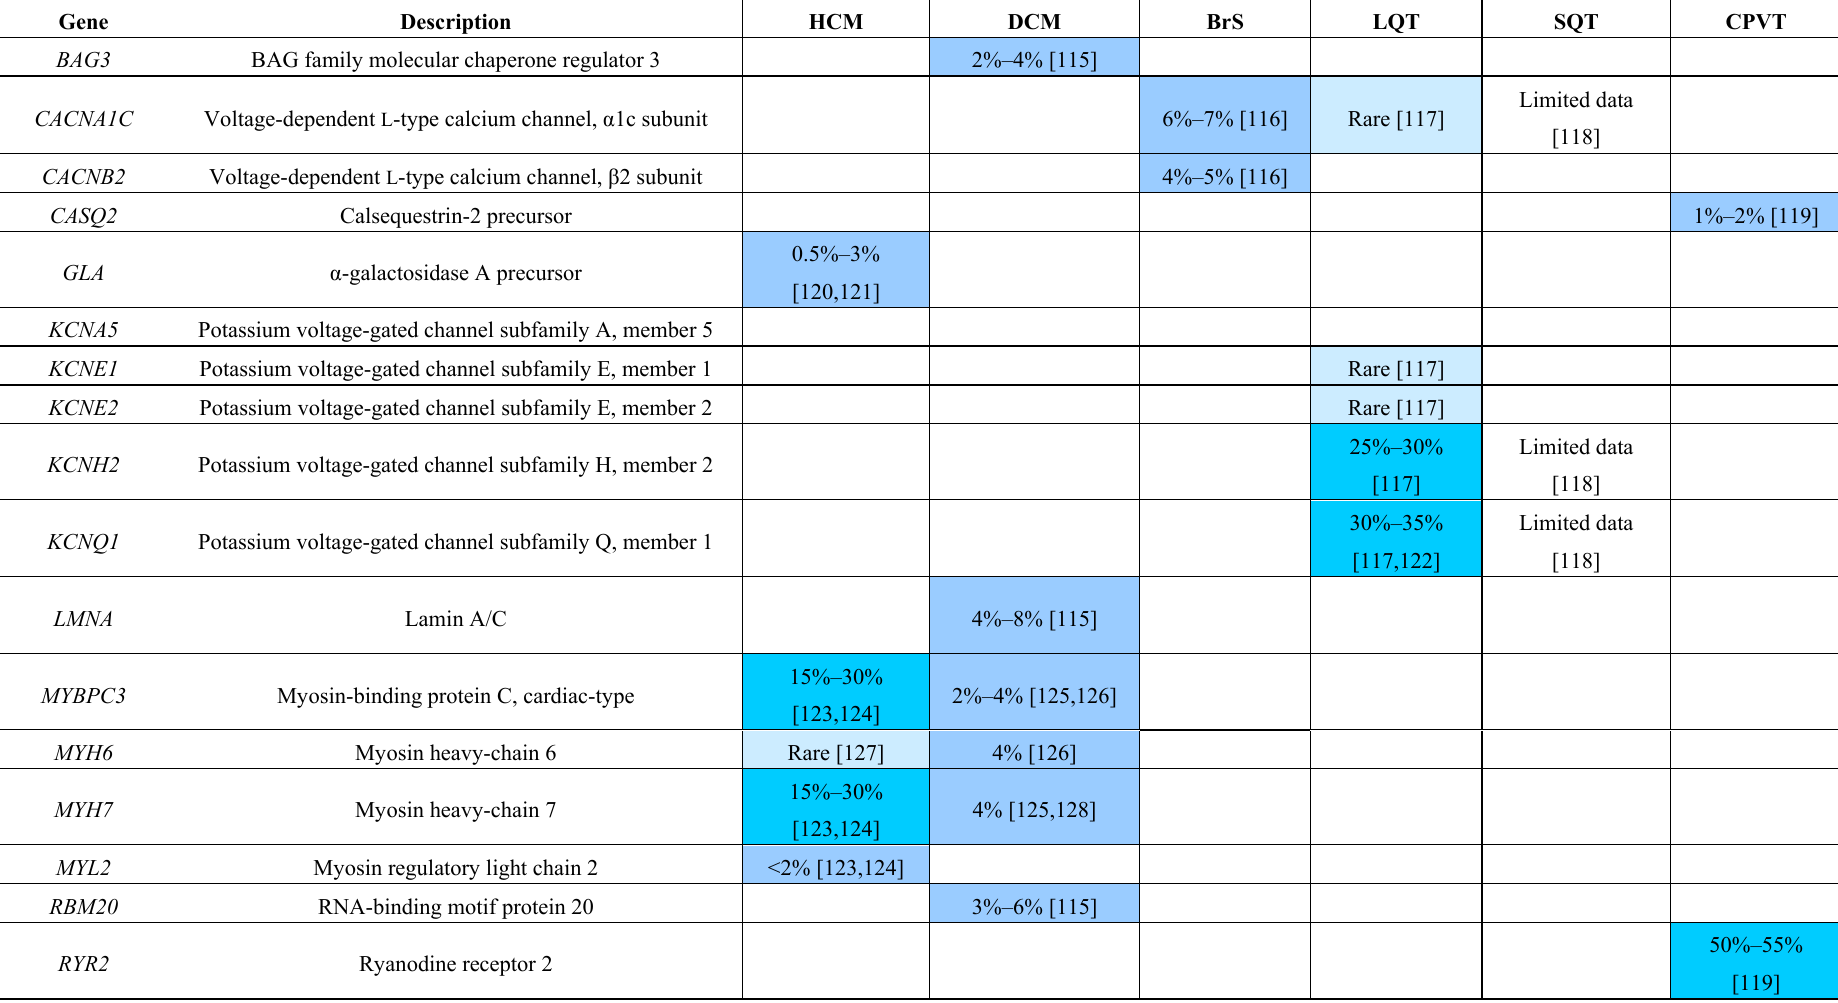
Table 5. The list of high incidence genes associated with five heritable cardiac disorders associated with sudden death.